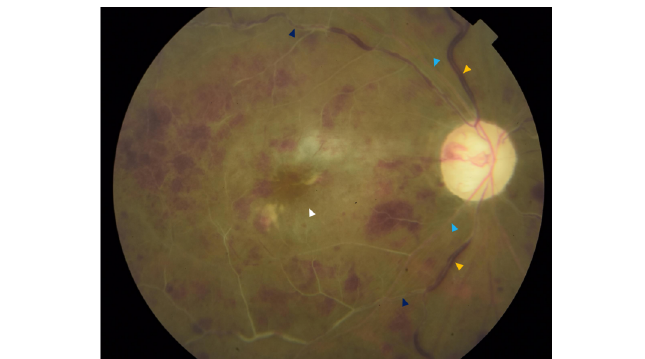
Figure 3: Fundus photograph showing features consistent with both CRAO and CRVO, including dilated and tortuous veins (yellow arrowhead), ischemic retinal whitening with a cherry red spot (white arrowhead), and sclerosed arteries (light blue arrowhead), as well as sclerosed veins with boxcarring of red blood cells (dark blue arrowhead)